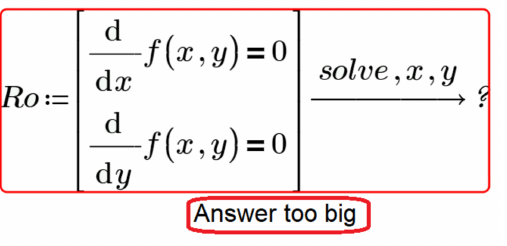
Figure 27. Incorrect solution of a system of equations composed of the partial derivatives of the Himmelblau’s function.